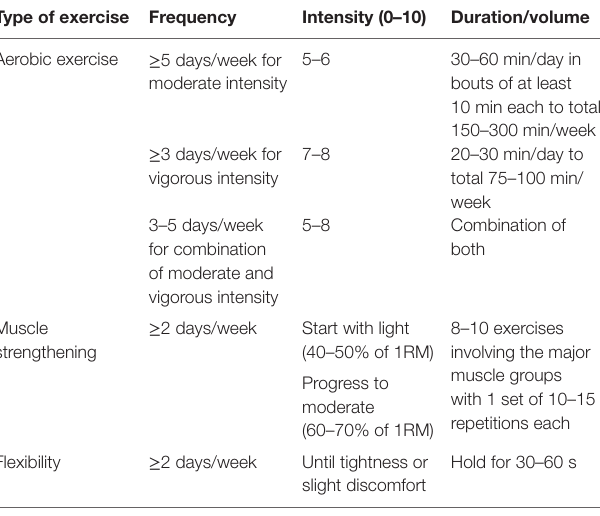
TABLe 1 | General guidelines for exercise prescription in older